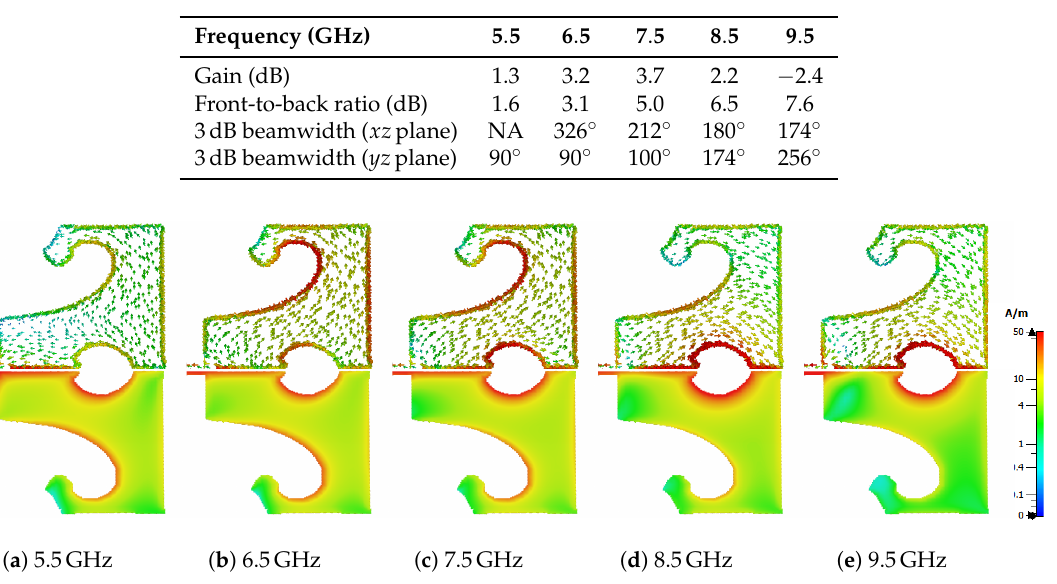
Figure 14. Antenna IV: ( a ) Realized gain in the xz plane ( φ = 0). ( b ) Realized gain in the yz plane ( φ = 90). The maximum cross-polarization level is less than 52dB and 44dB for φ = 0 and φ = 90, respectively. Table 4. Maximum gain and 3dB beamwidths of Antenna IV (Figure13).